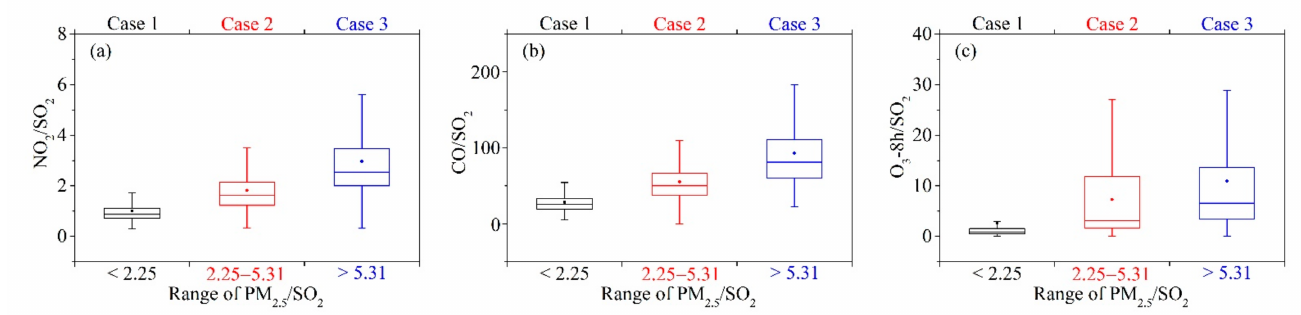
Figure 7. The ratio characteristics of air pollutants between Case 1, Case 2, and Case 3. ( a ) NO 2 /SO 2 , ( b ) CO/SO 2 , ( c ) O 3 -8 h/SO 2